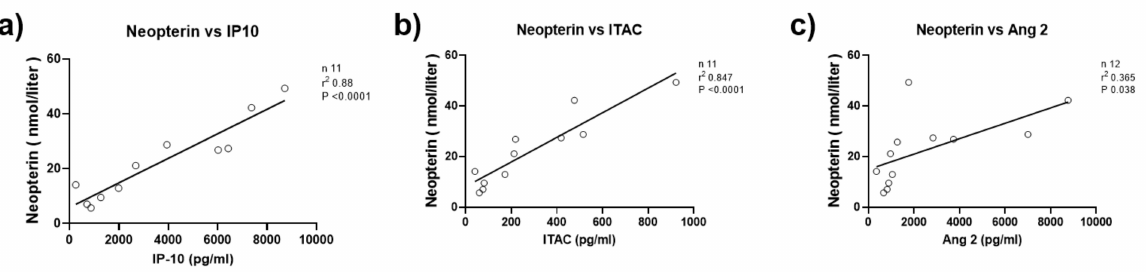
Figure 3. Serum neopterin levels are highly correlated with other biomarkers of disease activ- ity: IP-10 (CXCL10), I-TAC, and angiopoietin 2 (Ang2). ( a ) Shows a strong correlation between serum neopterin level and with CXCL10 (IP-10: interferon gamma-induced protein 10) in untreated JDM subjects (r 2 = 0.88, p < 0.0001). ( b ) Shows a strong correlation between serum neopterin level and CXCL11 (I-TAC: interferon-inducible T-cell alpha chemoattractant) in untreated JDM subjects (r 2 = 0.85, p < 0.0001). ( c ) Shows significant correlation between angiopoietin 2 and serum neopterin level (r 2 = 0.37, p =